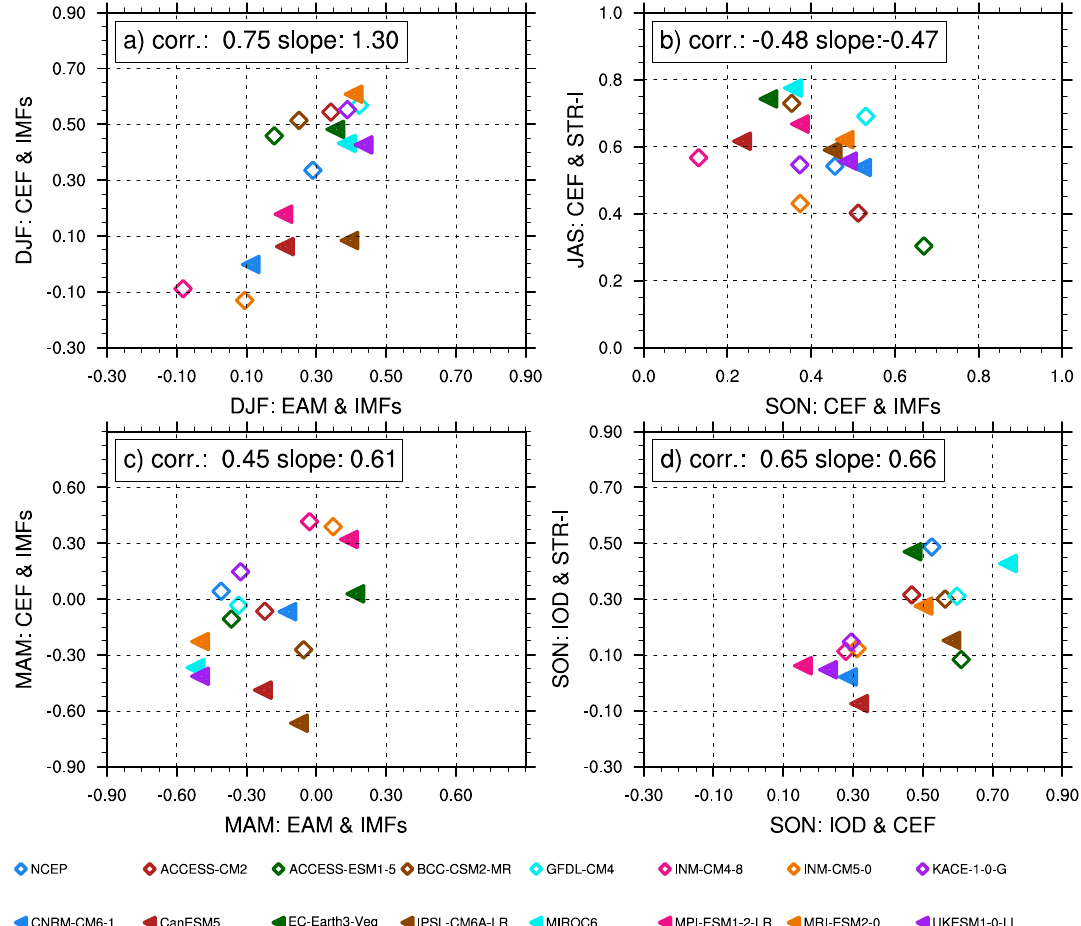
Figure 5. Scatterplot of the correlation coefficient between different indices. ( a) The correlation between EAM and IMFs 6–8 in December, January, and February (DJF) against the correlation between CEF and IMFs 6–8 in DJF. The correlation in this pair is 0.75 and passes the 99% significance level. The results show a joint relation of EAM and CEF to IMFs 6–8 in DJF. ( b) The CEF has a significant relationship with IMFs 6–8 in SON, when the CEF is strongly correlated with the intensity of the Australian subtropical ridge (STR-I) in JAS. The correlation between this pair is negative, which means that the strong influence of the STR-I in JAS might reduce the triggering of westerly anomalies by CEF in the following season. ( c) Both EAM and CEF are negatively correlated to the westerly wind anomaly in MAM. The interaction of both is positively correlated with IMFs 6–8, with a correlation value of 0.45. ( d) The scatter plot shows that the IOD has a partial impact on both STR-I and CEF in SON; however, there is no significant direct impact on the IMFs Pacific, strong anomalous northerlies in boreal winter (associated with the EAM) converge with strong anoma- lous southerlies (related to the Australia monsoon) to produce westerly anomalies in the western Pacific region. We found that the EAM is highly associated with these non-ENSO-related westerly wind anomalies (IMFs 6–8), which are subsequently enhanced in DJF in the East Asia-western Pacific region. Another type of WWB event, induced by cross-equatorial anomalous southeasterly winds along the Australian continent in JJA and SON, further increases the wind stress anomaly in the equatorial western Pacific 24 . Both the EAM and CEF initiate westerly wind anomalies, which may conducive to downwelling Kelvin waves that move warm SSTa from the western Pacific eastward. Another factor considered to be an ENSO precursor is the southerly surge originating in east Australia along 150°E and flowing into the equatorial region. This southerly surge is associated with the CEF over the Australian monsoon region 24 . We also found that the CEF is directly linked to the intensity of the Australian subtropical ridge (STR-I). The STR is well quantified in the east due to a relatively high density of SLP observations in the area, and indices show that the maximum intensity and northerly extent of SLP occur from June to August and that it reaches its minimum intensity from January to February. Nevertheless, in MAM, both factors retreat, and no main climate driver is acting on the western Pacific in these months, other than the background trade wind. In MAM, both factors provide a weak or negative influence on the WWBs in both observations and CMIP6 models. The zonal wind in the western Pacific remains easterly and develops every year. It may explain the easterly event in 2014 that halted the development of an extreme ENSO event. Our second main finding is that there is no direct link between the Australian STR and westerly wind anomalies in the western Pacific warm pool region. While previous studies 38 concluded that the STR strengthens